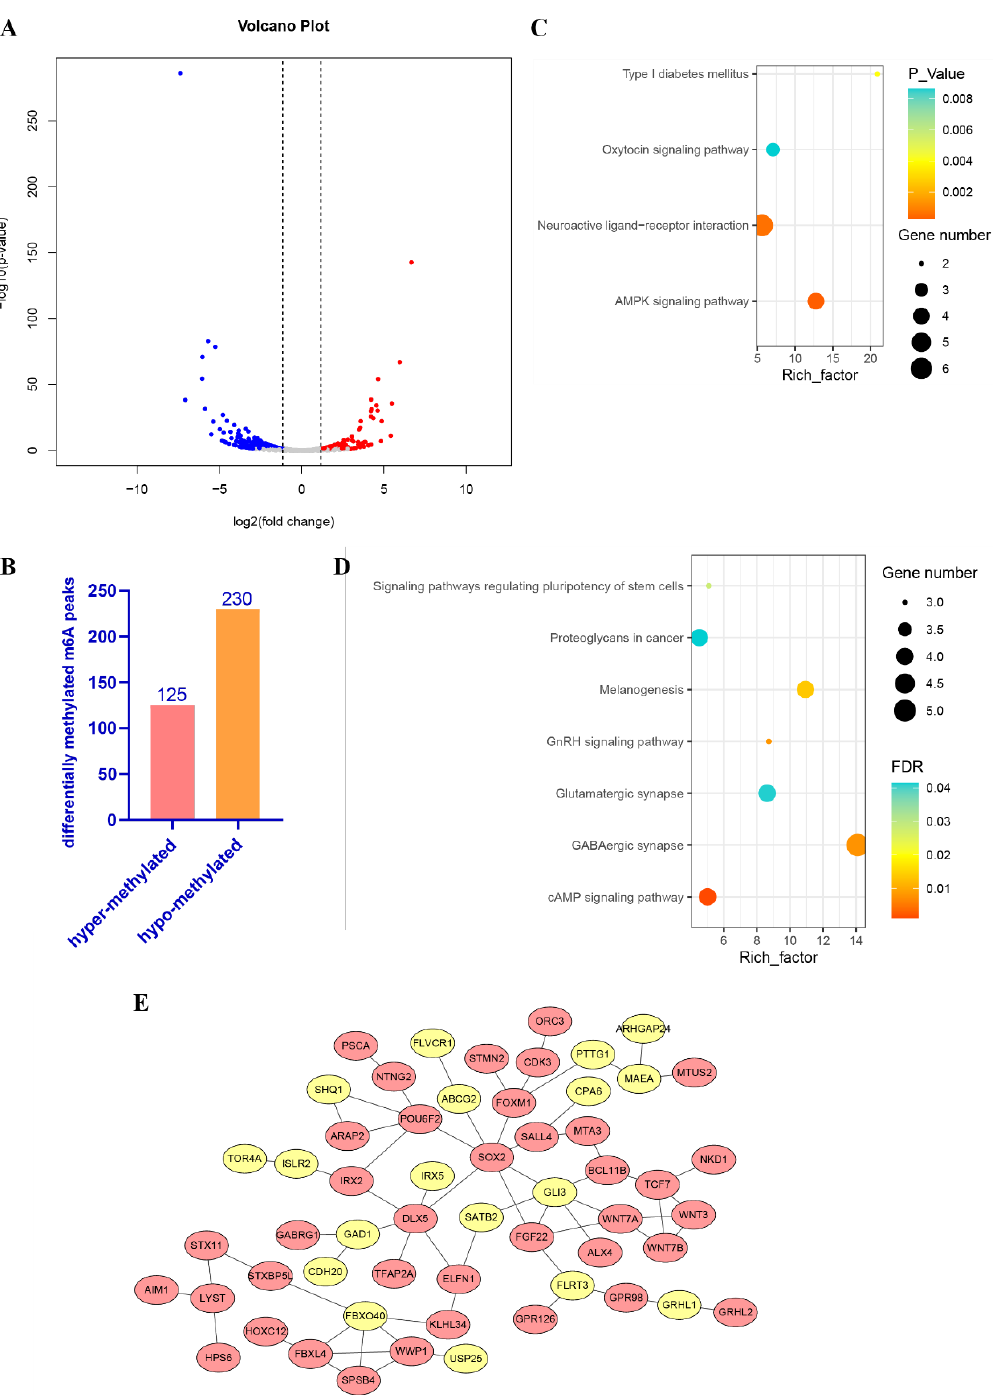
Figure 3. The dynamic changes in m6A modification in E13 and E19. ( A ) Volcano charts showing abundance of the intersection m6A peaks in E19 and E13. The differentially methylated peaks were chosen based on a p value of < 0.05 and |log2FC| > 1. ( B ) The number of differentially methylated peaks in intersection peaks in E19 and E13. ( C ) KEGG enrichment analysis of the hyper-methylated peak genes in E19 and E13. The pathways with p value < 0.01 are shown. ( D ) KEGG enrichment analysis of the hypo-methylated peak genes in E19 and E13. The pathways with FDR < 0.05 are shown. ( E ) The protein–protein interaction network of differentially methylated peak genes. Yellow nodes stand for the hyper-methylated peak genes; the pink nodes indicate the hypo-methylated peak